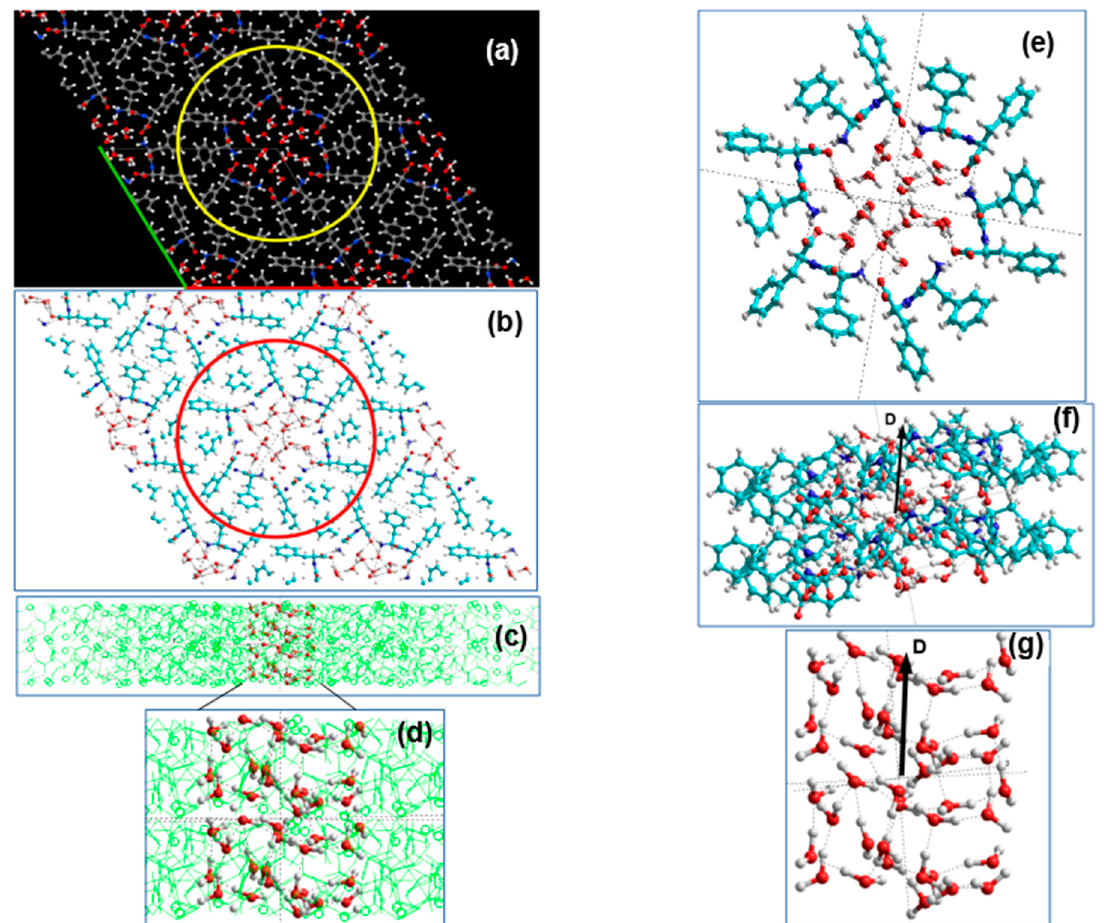
Figure 6. Schematics of the L-FF PNT structures with optimized 21 H 2 O per unit cell embedded water cluster (the designations used are the same as in Figure 4): ( a ) Z-projection image from VASP computed data with four unit cells; ( b ) the same image converted into HyperChem workspace; ( c ) side Y-projection and cross-section of L-FF structures with selected water molecules formed initial water cluster; ( d ) inset with biggest image of water cluster; ( e ) Z-projection image of the L-FF 2 coils with 42 H 2 O embedded water cluster; ( f ) Y-projection image of the L-FF 2 coils with 42 H 2 O embedded water cluster ( D show the total dipole momentum); ( g ) Y-projection image of the 42 H 2 O water cluster extracted from L-FF PNT after optimization ( D shows the total dipole momentum for water cluster).